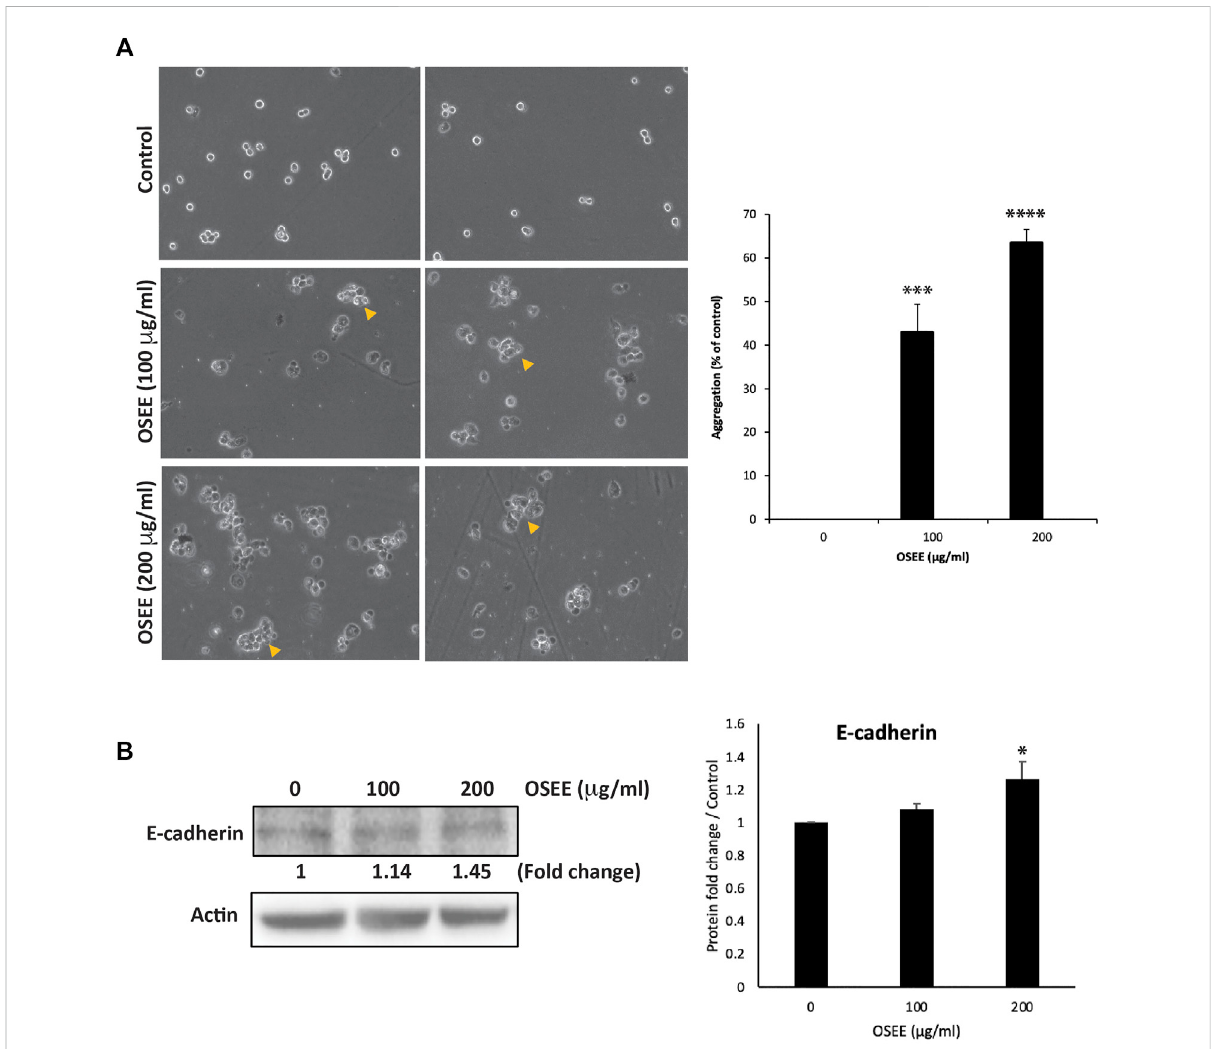
FIGURE 7 O. syriacum increases the cell-cell aggregation of MDA-MB-231 cells. (A) MDA-MB-231 cells were incubated with and without the indicated concentrations of OSEE and subjected to a cell-aggregation assay as described in Materials and Methods. Micrographs of cells were taken after 1 h andthepercentageofcell-cellaggregateswasmeasuredusingthefollowingequation:%aggregation=(1 – Nt/Nc)x100,whereNtisthenumberof singlecellsinthecontrol andNcisthenumberofsinglecellsinthetreatedsample. (B) MDA-MB-231 cellswereincubatedwith andwithoutthe indicated concentrations of OSEE for 24 h, and whole-cell protein lysates were analyzed for E-cadherin protein levels by Western blotting. β -actin was used as a loading control. Data represent the mean ± SEM of three independent experiments ( n = 3). * p < 0.05, *** p < 0.001, **** p <